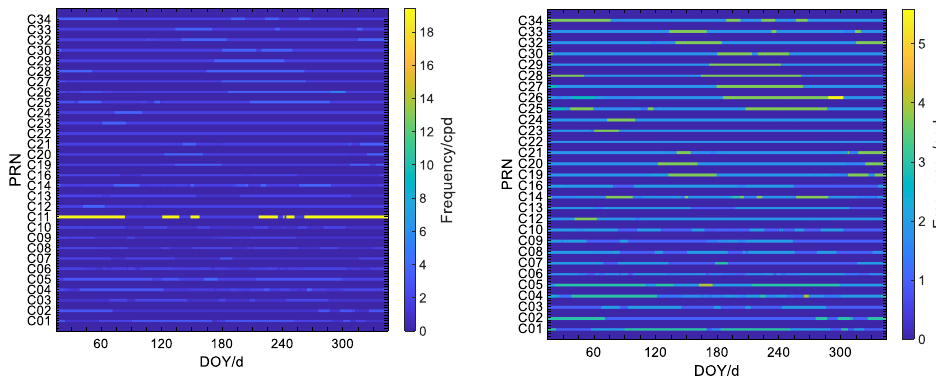
Figure 5. The frequency variations of main periodic term for 30 satellites (left), and 29 satellites except C11 (right).